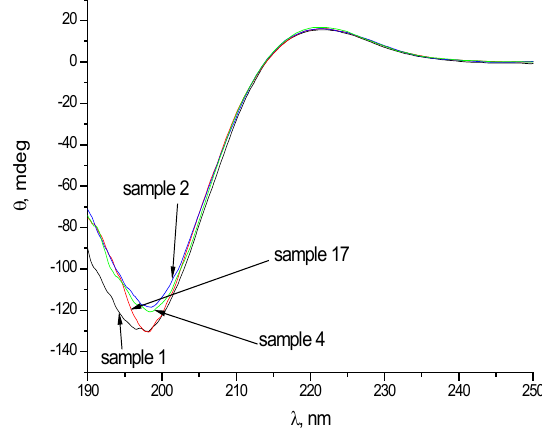
Figure 1. CD spectra (elipticity, θ , vs. wavelength, λ ) of collagen contained into Col (1), Col-Cr (2), Col-Cr-PHU (4) and Col-PHU-Cr